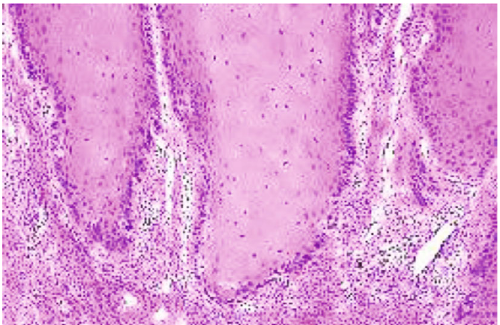
Figure 6: Histopathology of completely excised specimen showed verrucous con fi guration with a broad bulbous rete pegs with pushing margins in many areas along with features of mild dysplasia and few areas of parakeratin plugging (H&E, original magni fi cation: ×